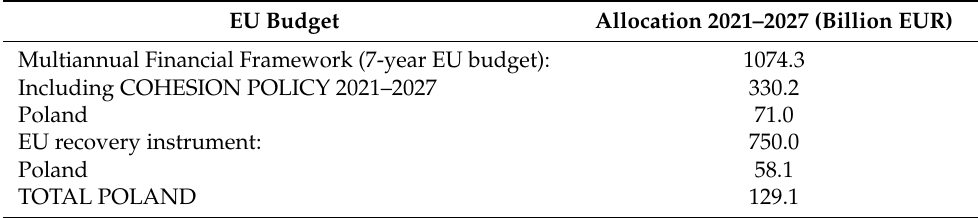
Table 1. Breakdown of EU allocation to Poland for 2021–2027. EU Budget Allocation 2021–2027 (Billion